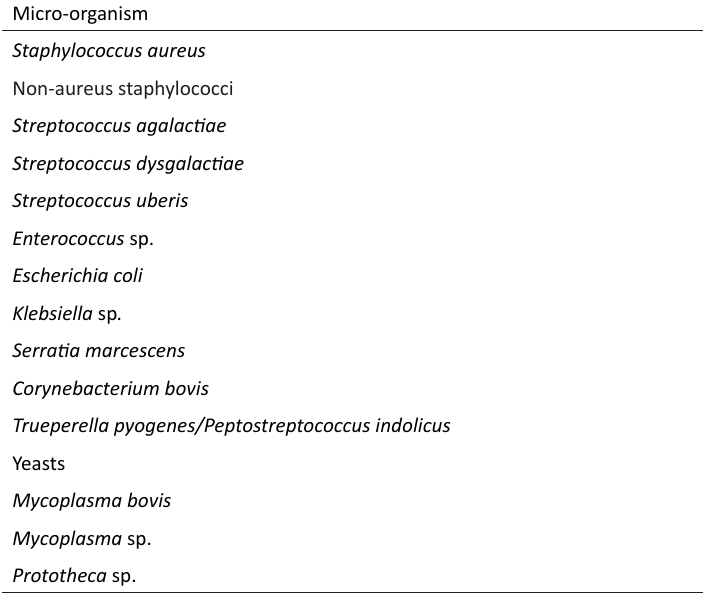
Table 2. Microbial DNA detectable in milk samples by the PathoProof™ Mastitis PCR Complete-16 Assay. The assay detects also the beta-lactamase gene of the genus Staphylococcus